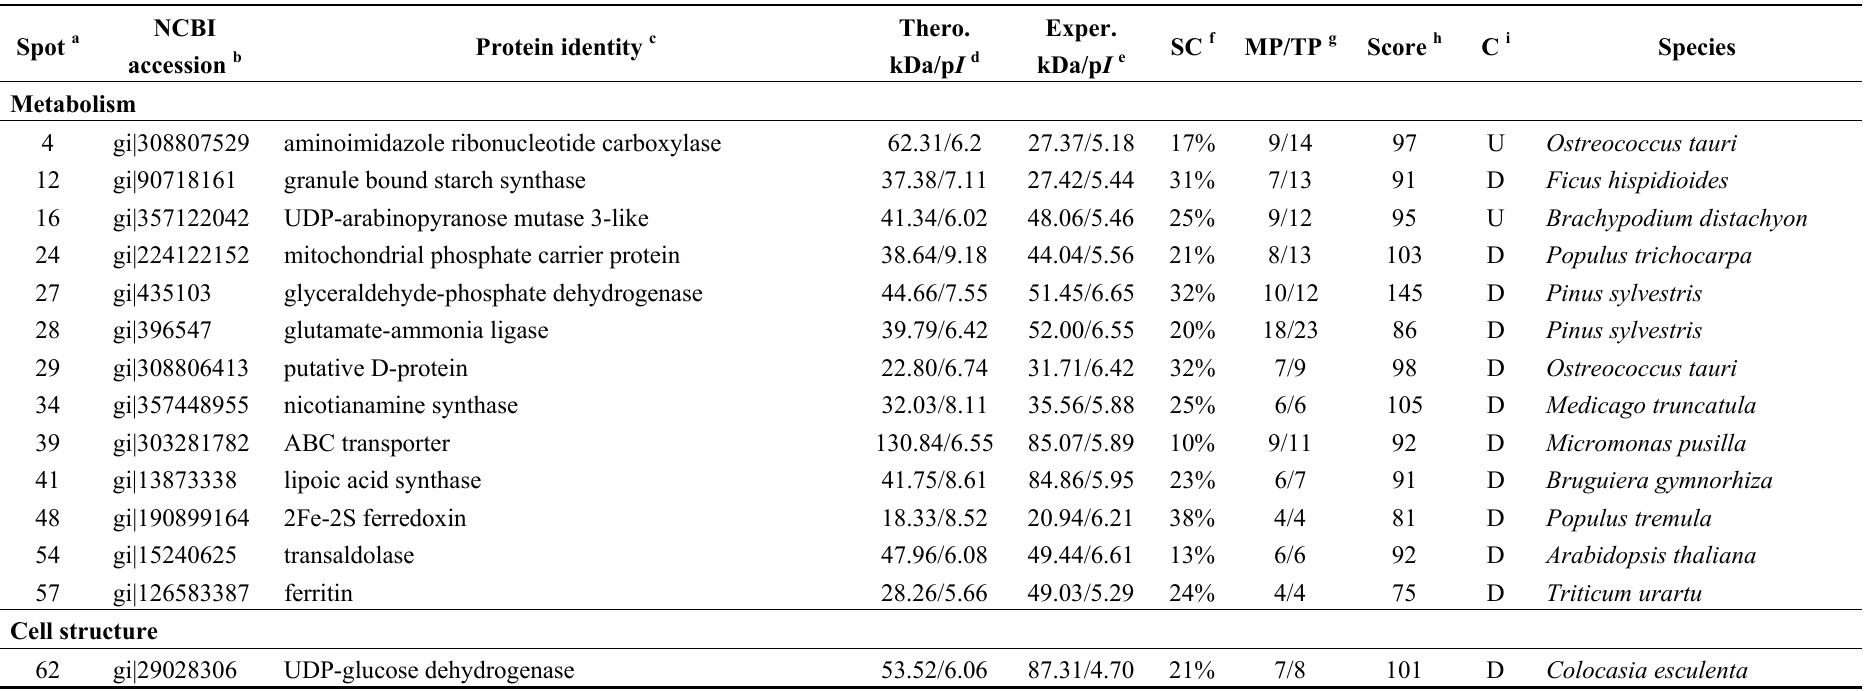
Table 1. Identification of differentially expressed proteins using 2-DE and mass spectrometry analysis in Pinus massoniana